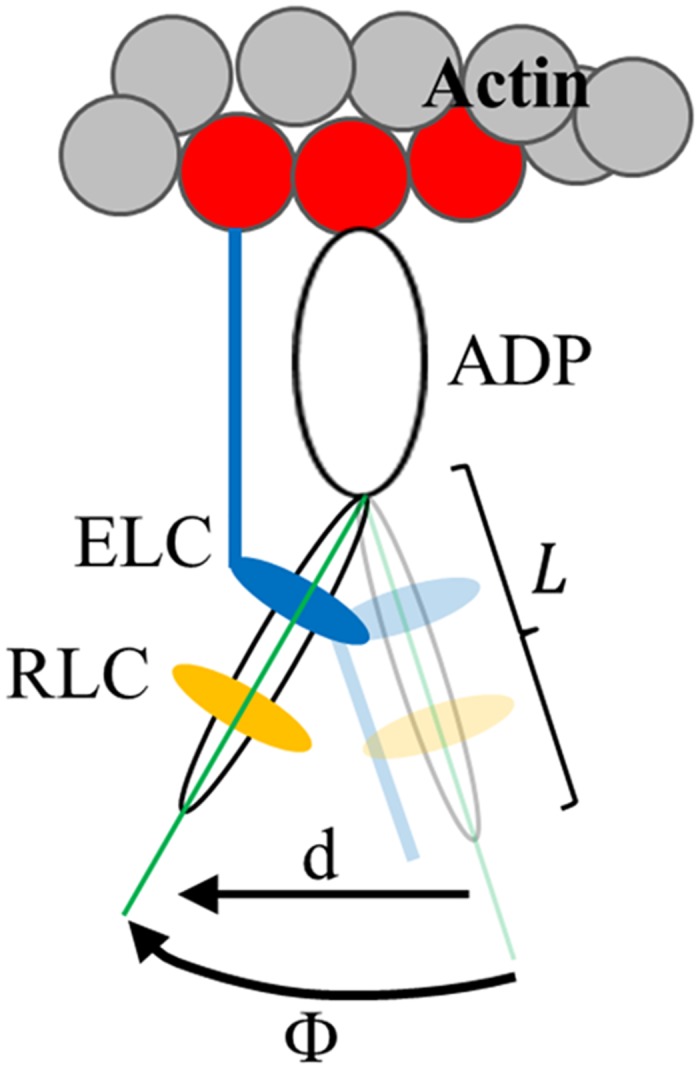
Myosin S1 consisting of a heavy chain, ELC (blue), and RLC (yellow) performing a powerstroke with a lever-arm rotation while strongly actin bound.The arc subtended by, Φ, the angle a single lever-arm helix rotates in sequential images defines a sequence of chords on a circle of diameter L equal to the lever-arm length indicated. Chord length is step-size, d, given by Eq 3. The ELC N-terminal extension, shown actin bound at the end of the powerstroke, plays a major role in the proposed mechanism for strain sensing in the myosin.